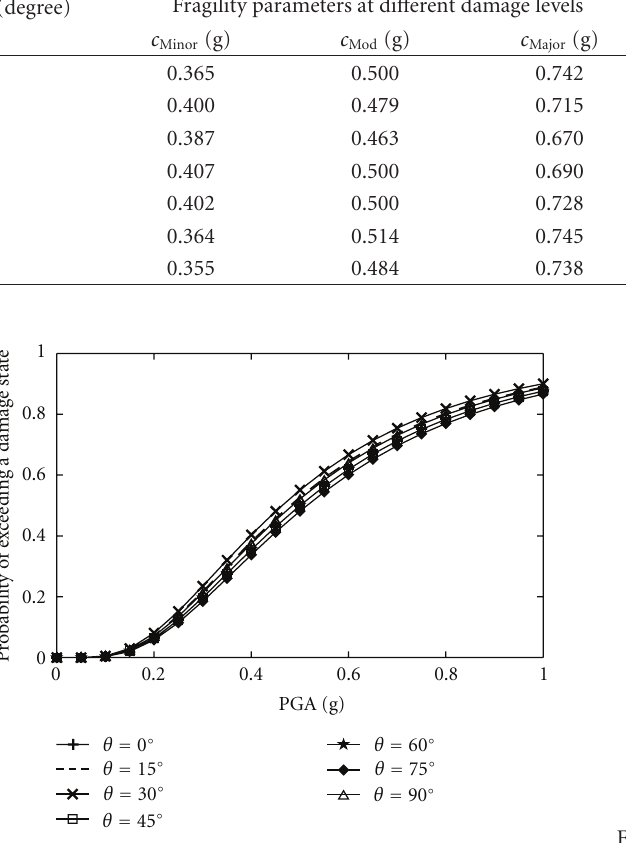
Figure 9: Fragility curves of the example bridge at moderate damage state (case I).